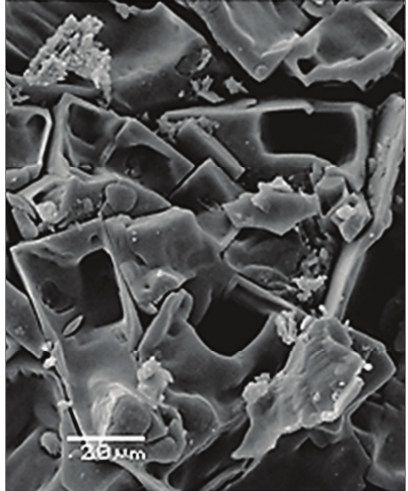
Fig. 9. Travertine pore spaces filled due to soil crystallization from solutions in the travertine from Hierapolis (with highest primary porosity)